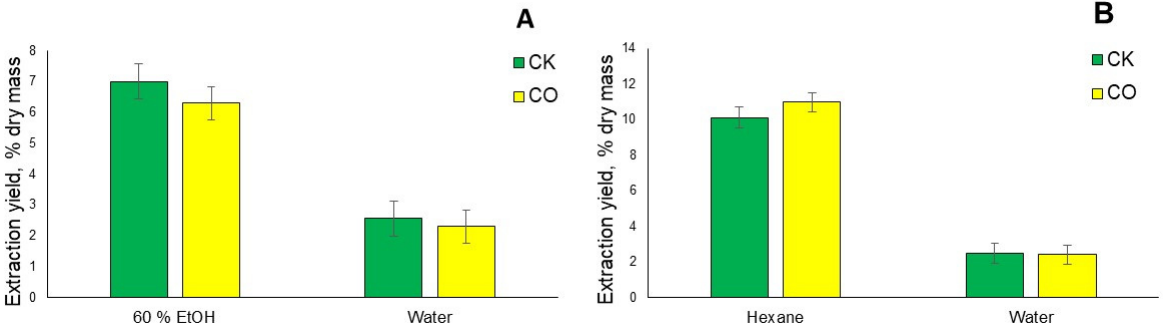
Figure 5. ( A ) Total extraction yield % of spent coffee ground sequential conventional extraction with a reflux condenser. ( B ) Total extraction yield % of spent coffee grounds sequential Soxhlet extraction with n-hexane and water ( n = 3, error bars indicate